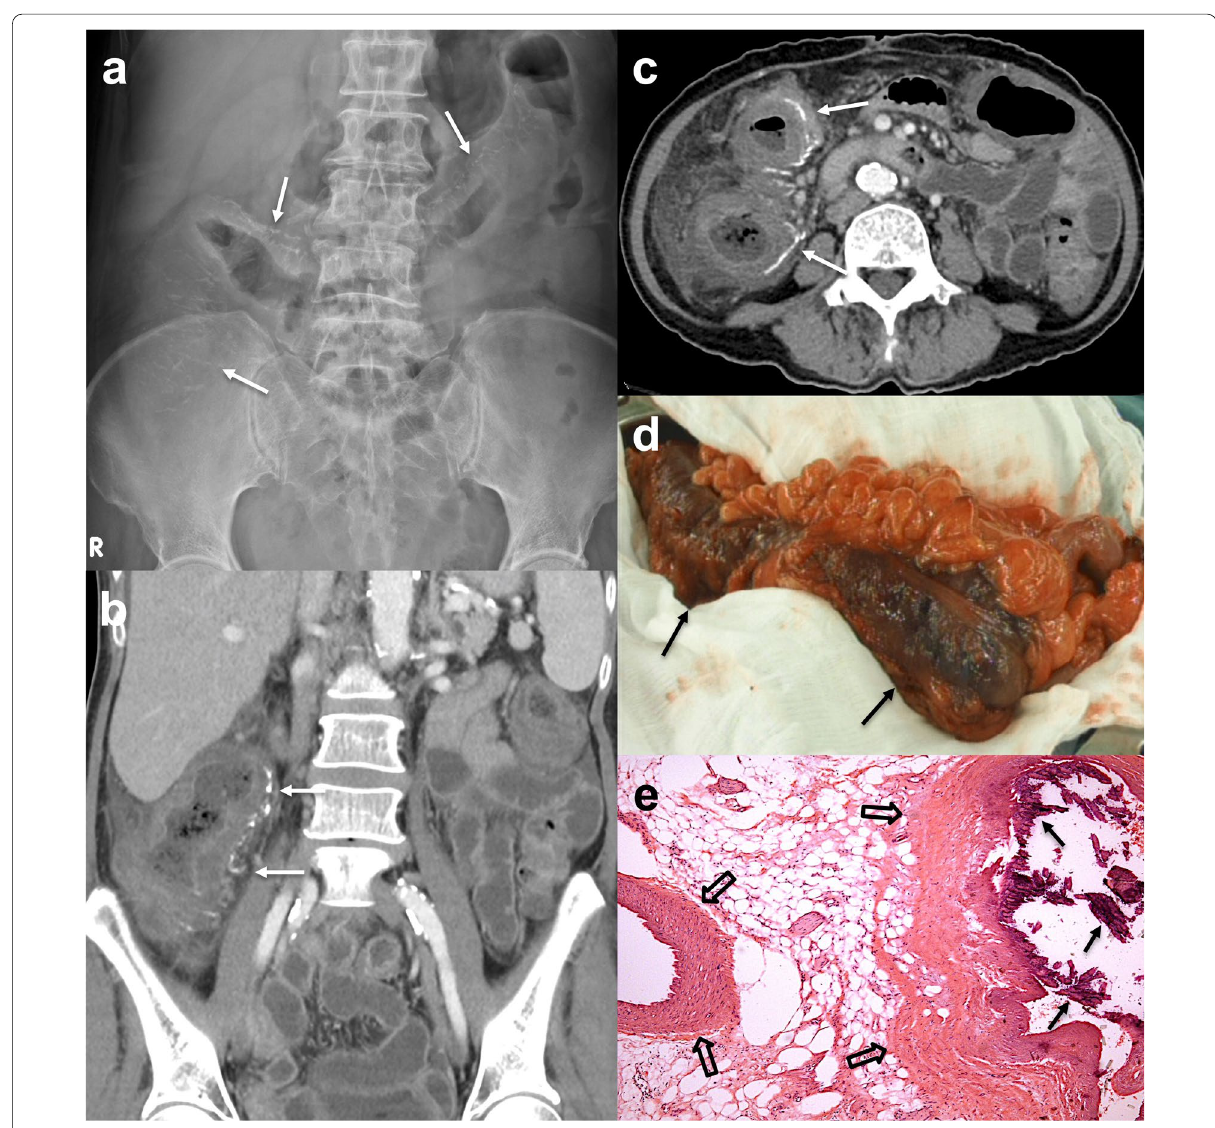
Fig. 2 A 72‑year‑old woman was admitted due to acute abdomen with severe abdominal pain for 2 days with tenderness and muscle guarding on palpation. a Plain radiograph shows curvilinear calcifications (arrows) alongside the right colon. b , c Axial and coronal CT show curvilinear calcifications of the straight and marginal veins alongside the ascending colon with thickened walls, prominent pericolic edema and inflammatory stranding. d Surgery revealed a swollen right colon with dark‑purple discoloration. e Photomicrograph (H and E, (open arrows) with marked fibrosclerotic wall thickening and intraluminal calcifications (black arrows), confirming